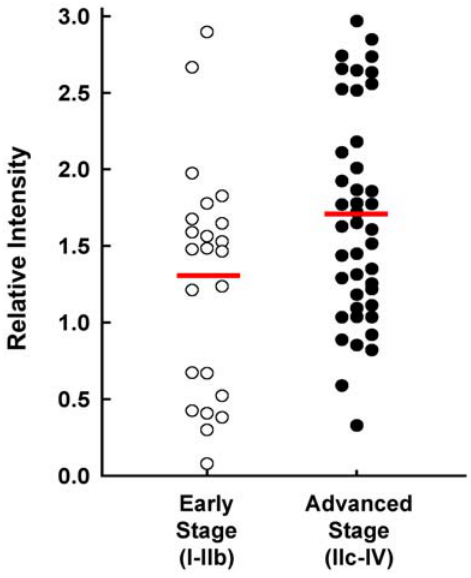
Figure 7. Reverse phase protein micorarray data obtained from the analysis of diagnostic sera from women with OVCA. Scatterplot displays relative intensity of serum S100A6 values for women with early stage (open circles, n=23) and advanced stage (closed circles, n=43) OVCA. The early stage disease group includes 2 tumors diagnosed as borderline OVCA. The means of the relative intensity values of the analyte concentrations shown (horizontal lines) are significantly different for the two groups (p=0.031, two-sample t- test), and depict relatively greater mean S100A6 concentration in sera of advanced stage